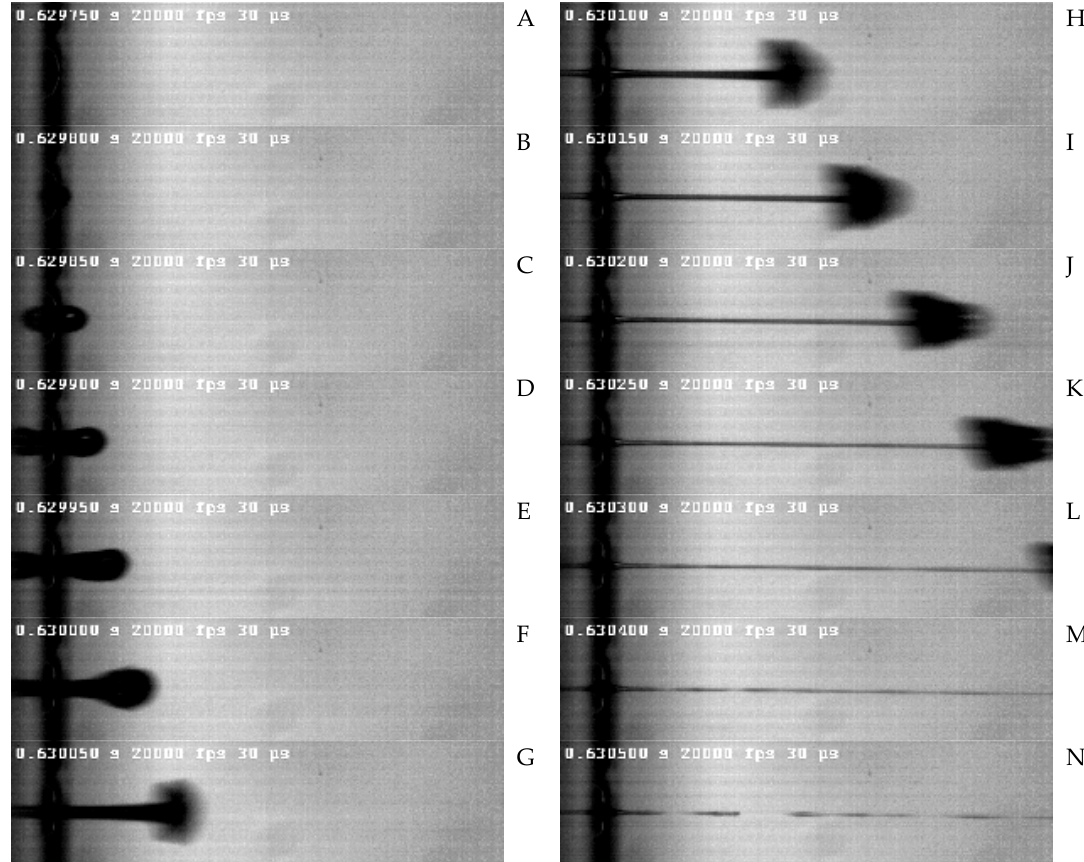
Figure 11: High-speed images of R3001 drop formation with a time-interval of 50 µs between frames. Figure 11. High-speed images of R3001 drop formation with a time-interval of 50 µ s between frames. Left from top to down: Frames 1 to 7. Right from top to down: Frames 8 to 14. Left from top to down: Frames 1 to 7. Right from top to down: Frames 8 to